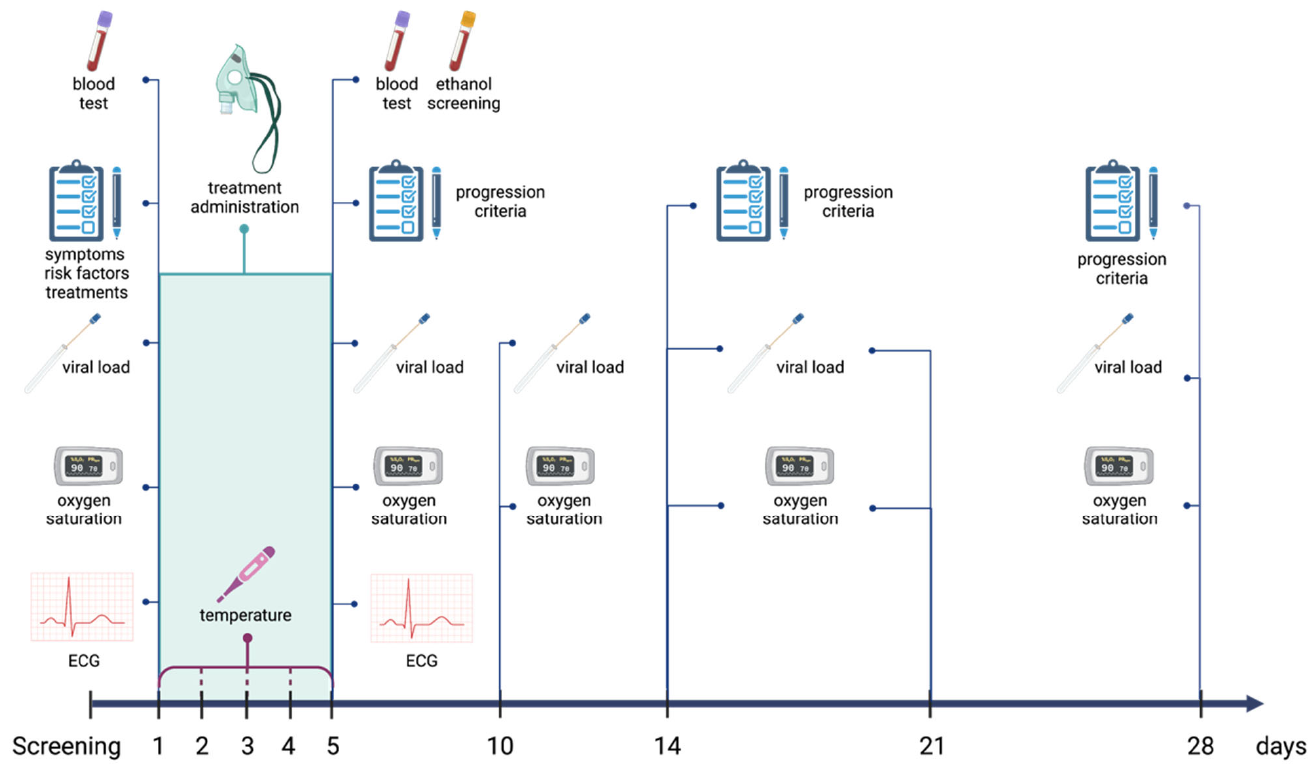
Figure 1. Trial design: study visits, collected variables and administration of the study medication. ECG: electrocardiogram. Created with BioRender.com.